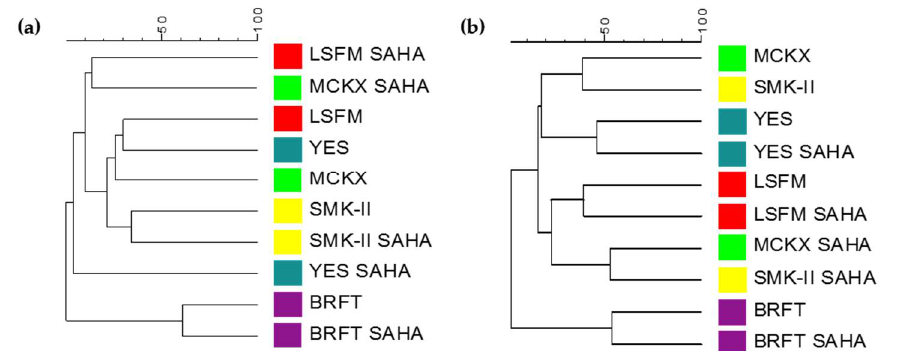
Figure 10. Dice-UPGMA dendrograms of metabolite profiles detected for the fungal strains; (a) Corticium sp. CF-166036 and (b) Microxyphium sp. CF-164412 grown in five fermentation media with and without SAHA.